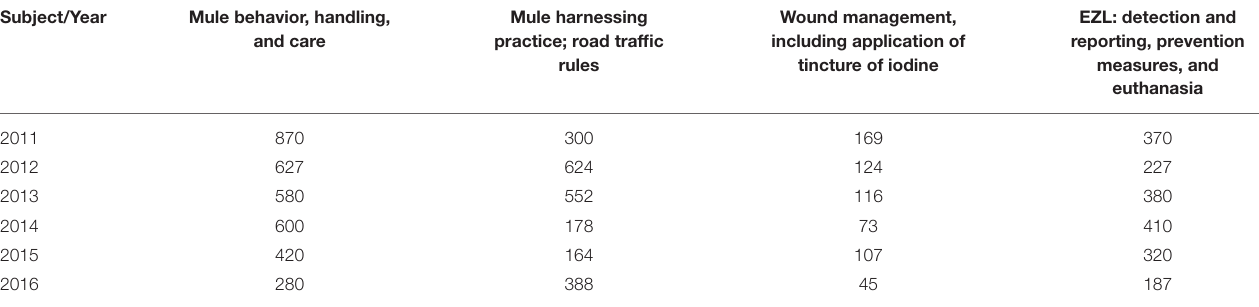
TABLE 6 | Numbers of muleteers attending different training